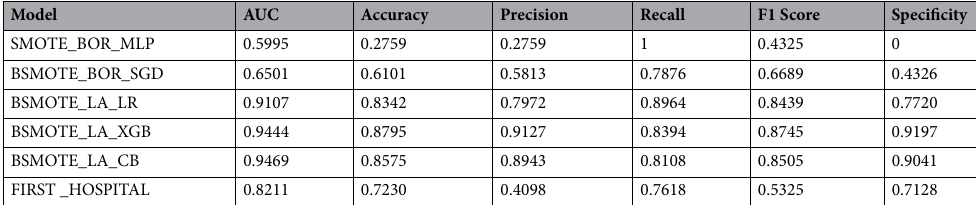
Table 3. Predictive performance indicators of the five best models and Chengdu First People’s Hospital. SMOTE synthetic minority oversampling technique, BOR boruta screening, MLP multilayer perceptron, BSMOTE borderline synthetic minority oversampling technique, SGD stochastic gradient descent, LA lasso screening, LR logistic regression, XGB extreme gradient boosting, CB category boosting, AUC area under the